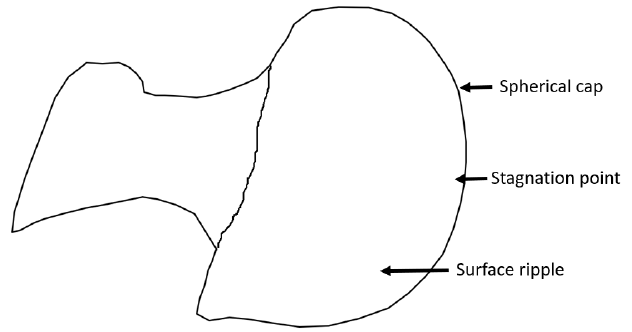
Figure 7. Description of emergence of the fuel near the nozzle outlet.